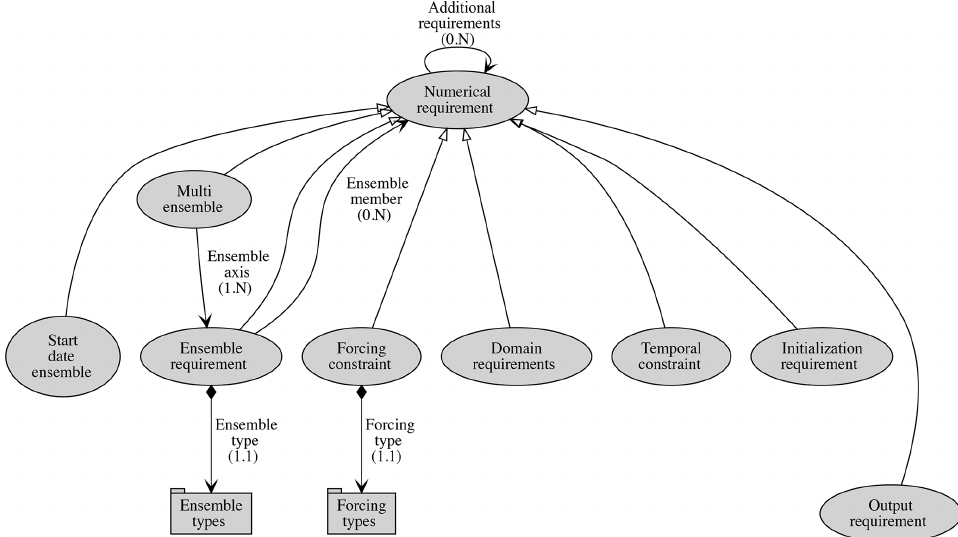
Figure 4. NumericalRequirements govern the structure of a numerical experiment covering constraints on duration ( TemporalConstraint ), the domain covered ( DomainRequirement , e.g. global or a regional bounding box), any forcings ( ForcingConstraint , such as particular green- house gas concentrations), OutputRequirements (e.g. the CMIP6 data request), and a complicated interplay of potential EnsembleRequire- ments (see text). Controlled vocabularies are necessary for EnsembleTypes , ForcingTypes , and NumericalRequirementScopes . Indices asso- ciated with the connectors indicate the numerical nature of the relationships; e.g. a NumericalRequirement can have anywhere between zero to many (0.N) additional requirements, whereas an EnsembleRequirement can have only one (1.1) EnsembleType